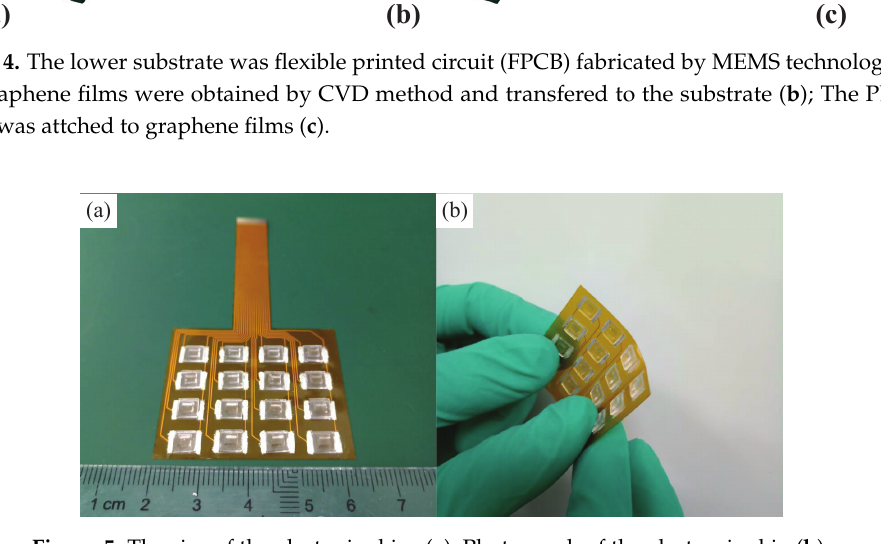
Figure 5. The size of the electonic skins ( a ); Photograph of the electronic skin ( b ).